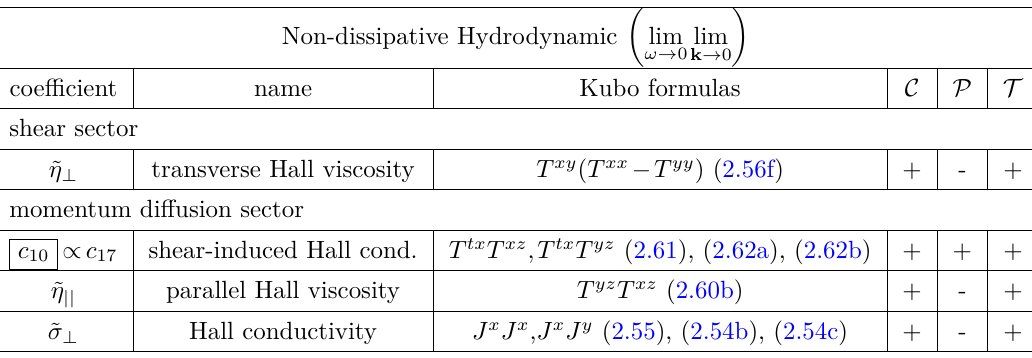
Table 4 . Independent non-dissipative hydrodynamic transport coefficients in a charged chiral ther- mal plasma subjected to a strong U(1) magnetic field. Similar to table 3. Note that the Hall A conductivity ˜ σ is dissipationless, however, it is computed from the resistivity matrix including ρ ⊥ and ˜ ρ , which are both dissipative. Here, “cond.” denotes “conductivity”. Boxed quantities are novel in this paper.